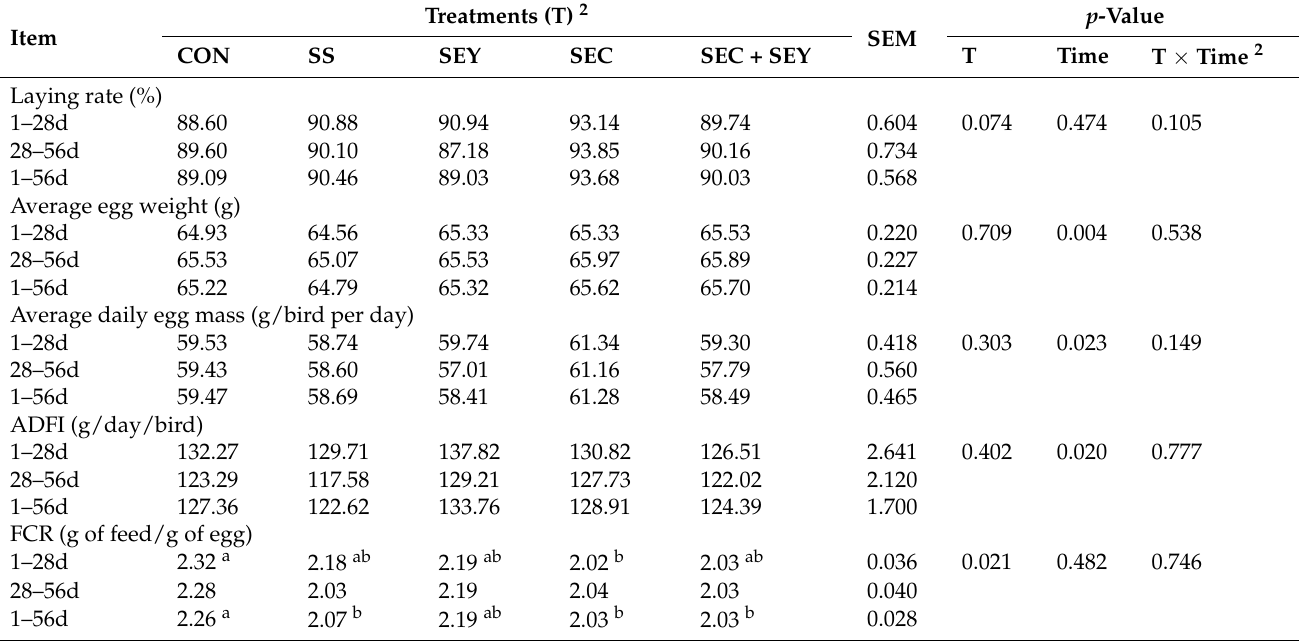
Table 3. Effects of different Se sources on laying performance in laying hens 1 .